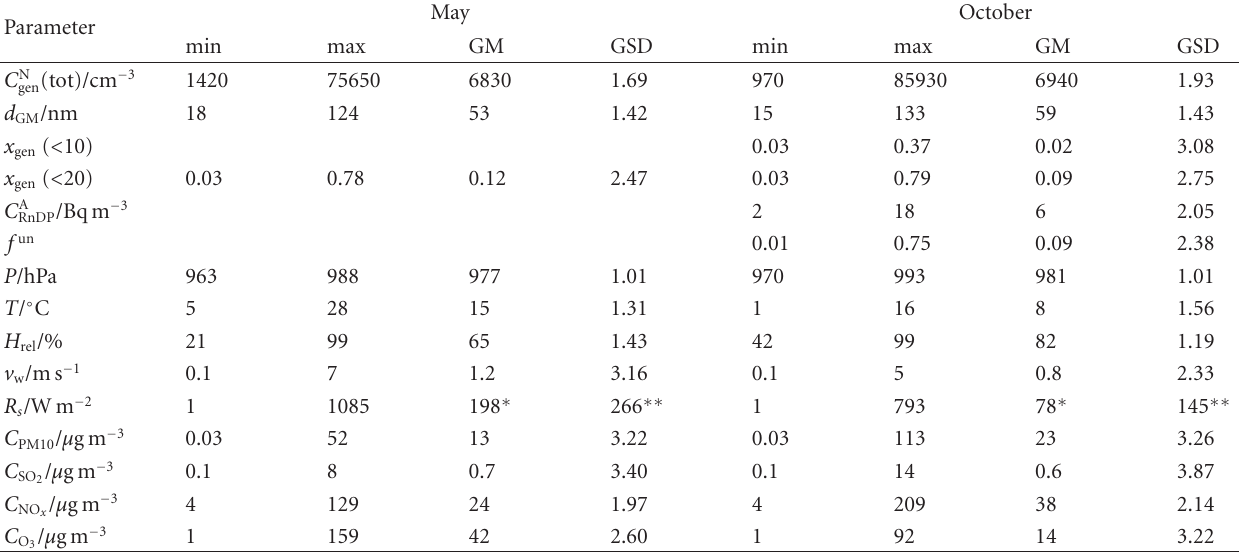
(tot)), geometric mean of number gen ), activity fraction of the unattached radon short-lived RnDP ), NO x ( C NO x ), and O 3 ( C O ) for the entire period of measurements 2 3